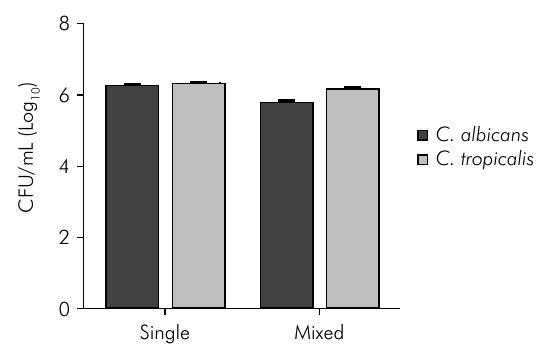
Figure 1. Mean values and standard deviation (n = 10) of CFU/mL (log) of C. albicans and C. tropicalis , organized in single and mixed biofilms. Student t-test. C. albicans counts: statistically significant difference between biofilm formed by C. albicans and biofilm formed by C. albicans + C. tropicalis (p < 0.0001). C. tropicalis counts: statistically significant difference between biofilm formed by C. tropicalis and biofilm formed by C. albicans + C. tropicalis (p = 0.0023).